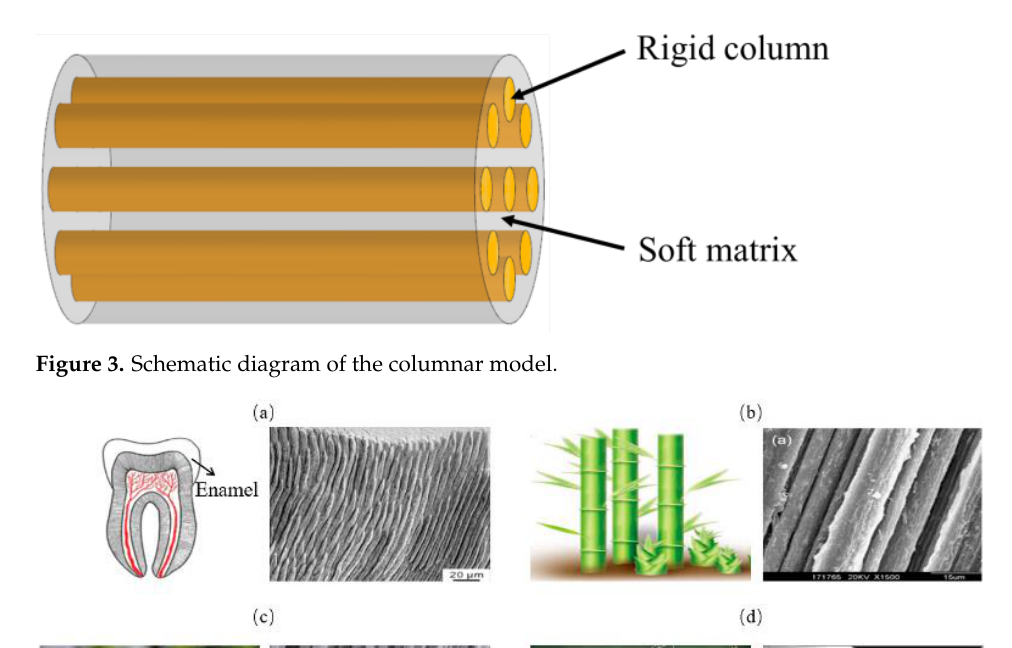
Figure 4. Columnar model in biological organisms. ( a ) tooth enamel [32] Copyright©2009, Bio-